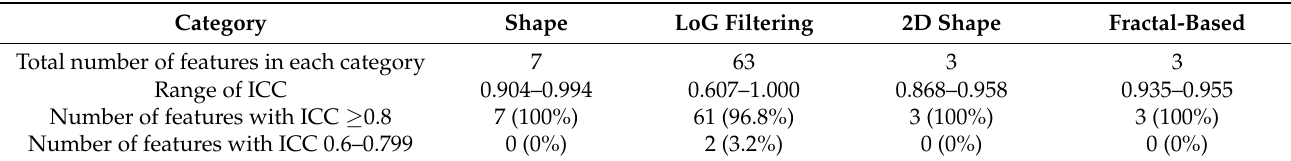
Table 1. Distribution of intraclass correlation coefficient (ICC) values according to the 4 categories. Nearly all radiomic margin characteristics showed excellent reproducibility.